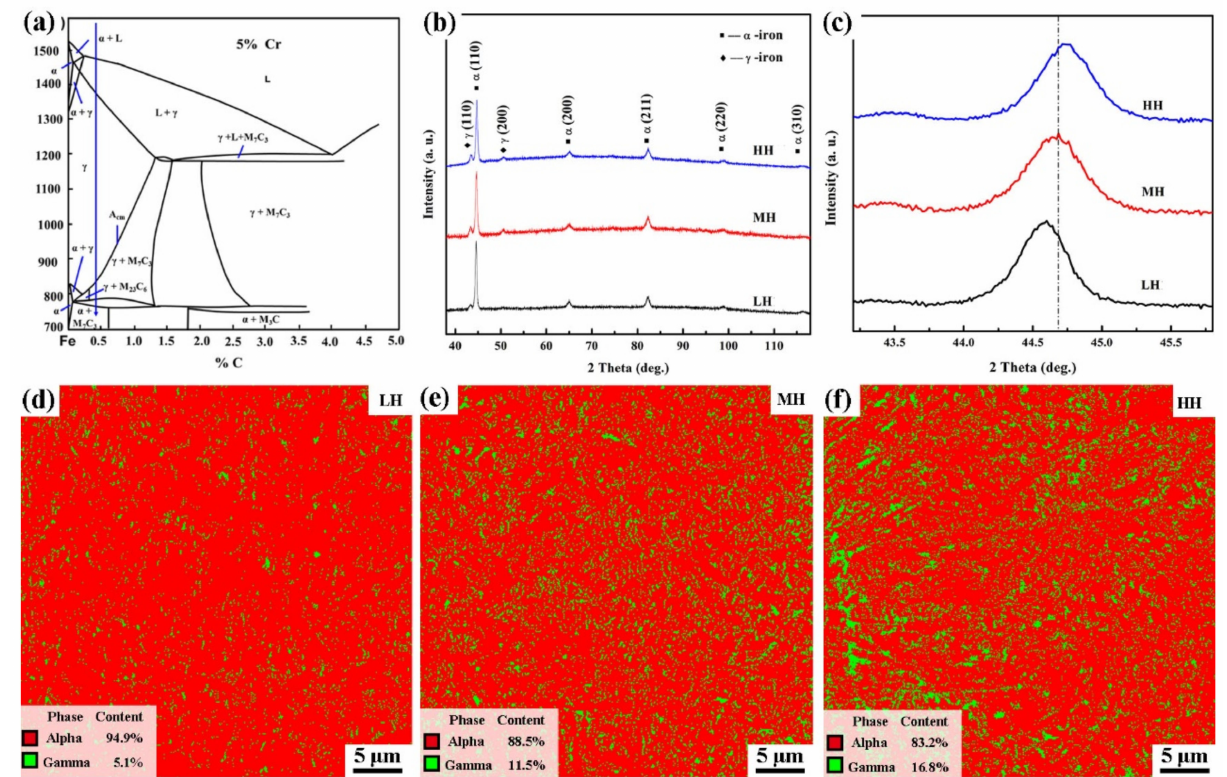
Figure 3. ( a ) The Fe-C (5% Cr) binary phase diagram, adapted from ref. [4]. ( b ) The XRD spectra of the as-built SLM-processed LH, MH, and HH. ( c ) The magnified image of the major α -iron peaks (110) of ( b ). ( d – f ) Phase distribution images of the as-built SLM-processed LH, MH, and